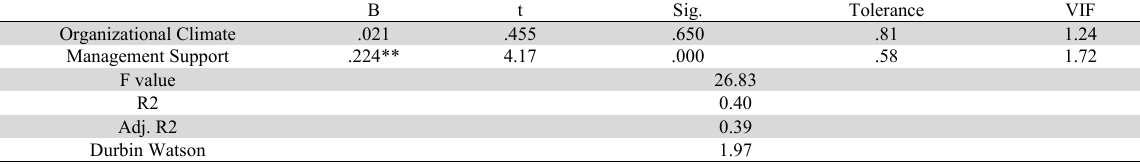
Regression Results of Independent Variables and Tacit Knowledge